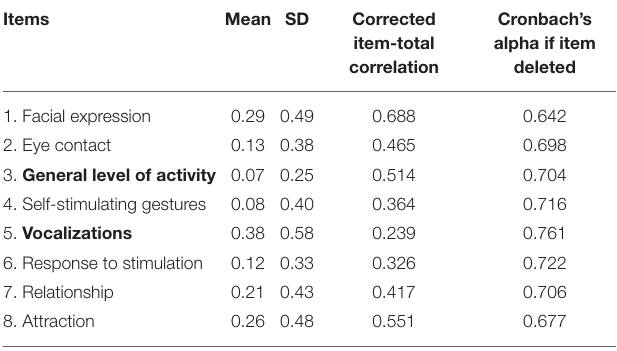
TABLE 3 | Internal consistency of the ADBB scale in the second evaluation.